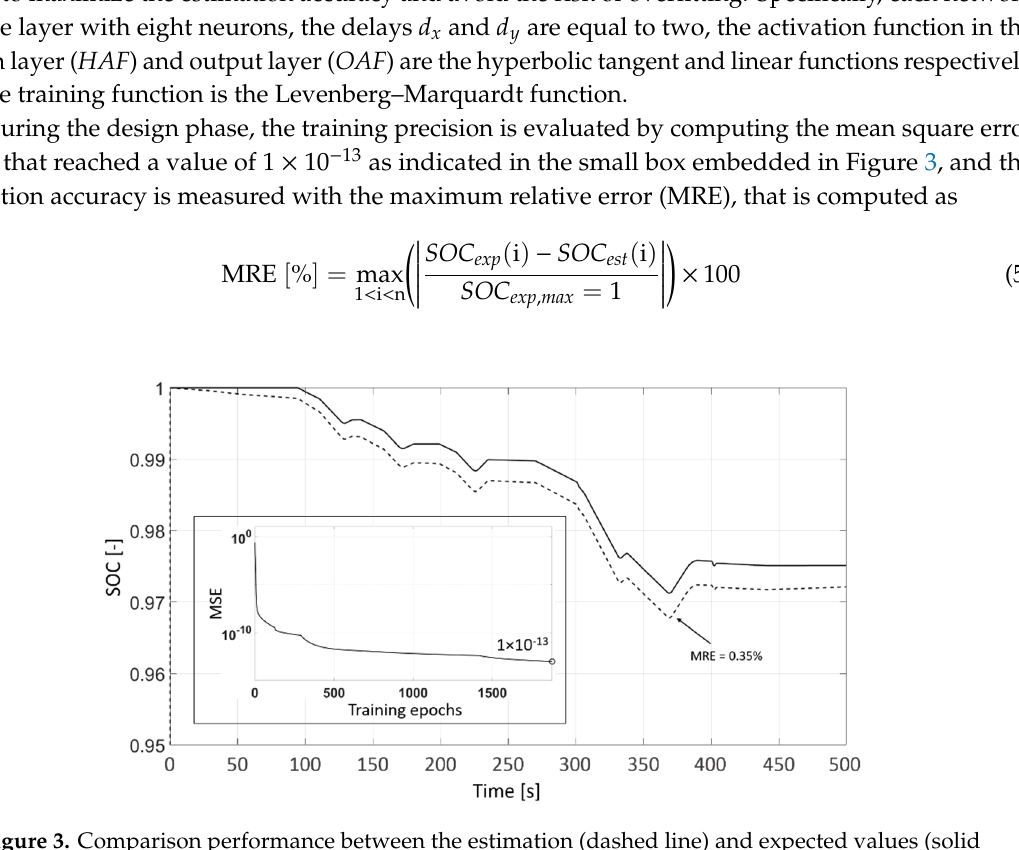
Figure 3. Comparison performance between the estimation (dashed line) and expected values (solid line) of the SOC in the case of an SOH = 100%. The obtained maximum relative error (MRE) is equal to 0.35%. The small box in the bottom left indicates the trend of the mean square error during the training phase.